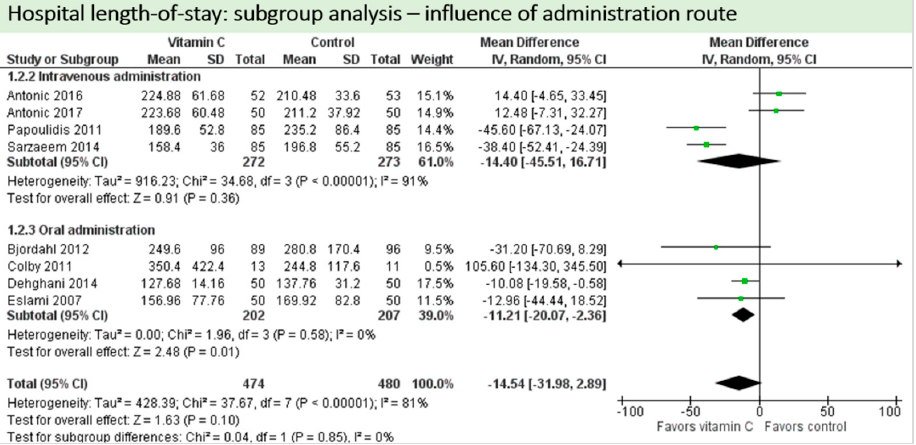
Figure 15. Hospital length of stay: subgroup analysis—influence of administration route.